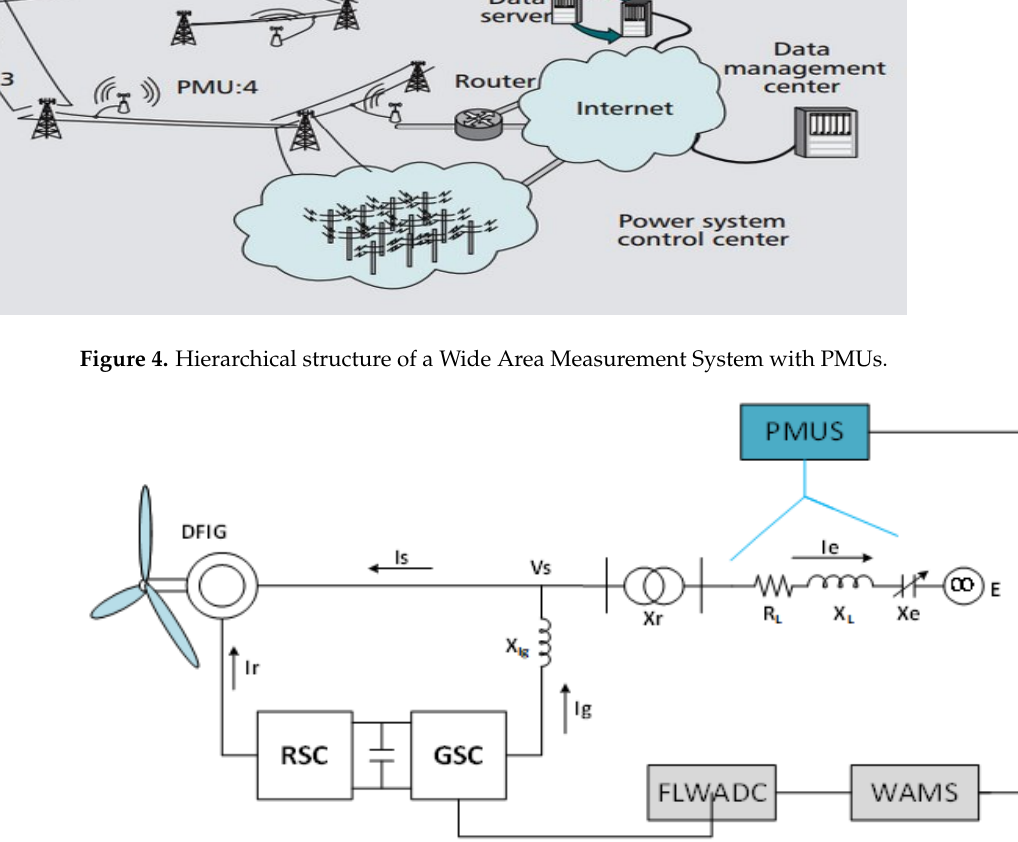
Figure 5. Location of fuzzy logic based on wide area in studied model.